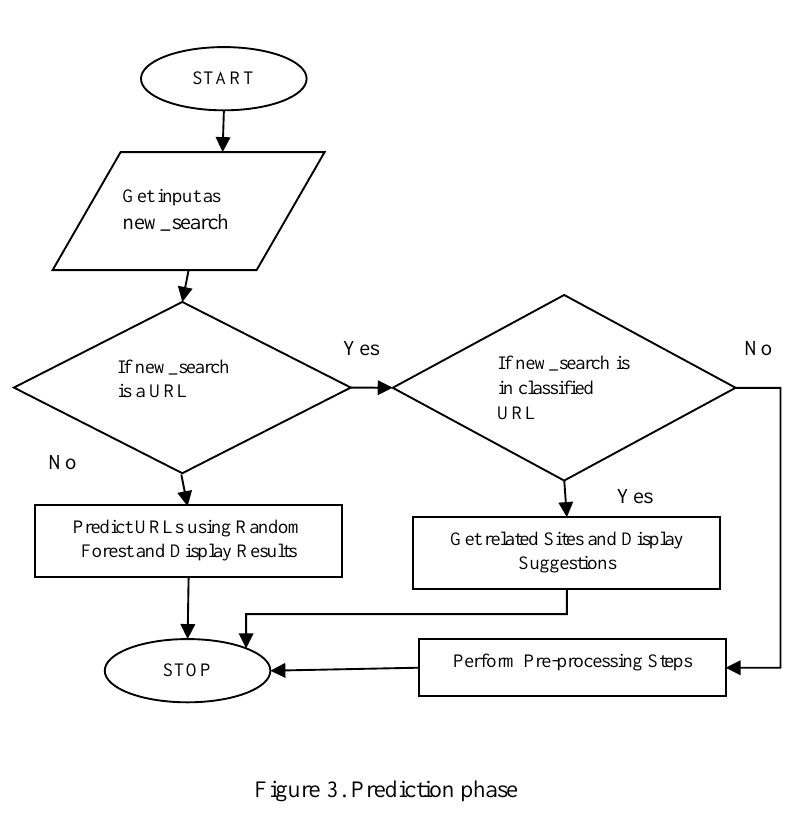
Figure 3. Prediction